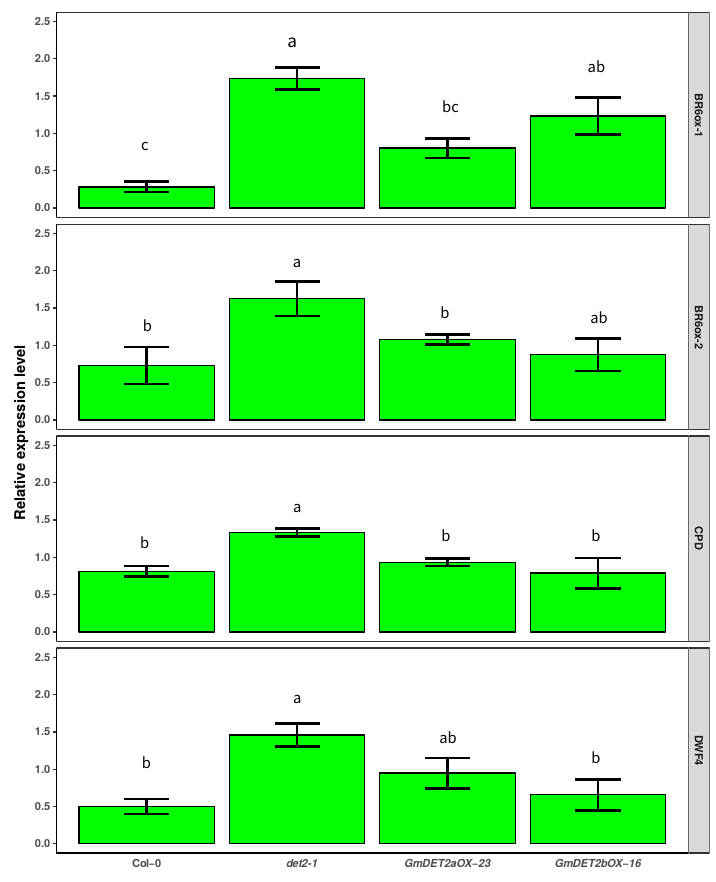
Figure 11. Effect of ectopic over-expression of GmDET2a and GmDET2b on the transcripts of BR biosynthesis-related genes in the Atdet2-1 mutant. Arabidopsis seedlings were grown as described in the Materials and Methods. Quantitative RT-PCR was used to quantify the relative expression levels of BR6ox-1 ( A ), BR6ox-2 ( B ), CPD ( C ) and DWF4 ( D ) in det2-1 and transgenic lines. Results are the means ± SD from four independent experiments with three technical repeats. One-way ANOVA was used to compare the difference among lines, with different letters indicating significant differences at the 0.05